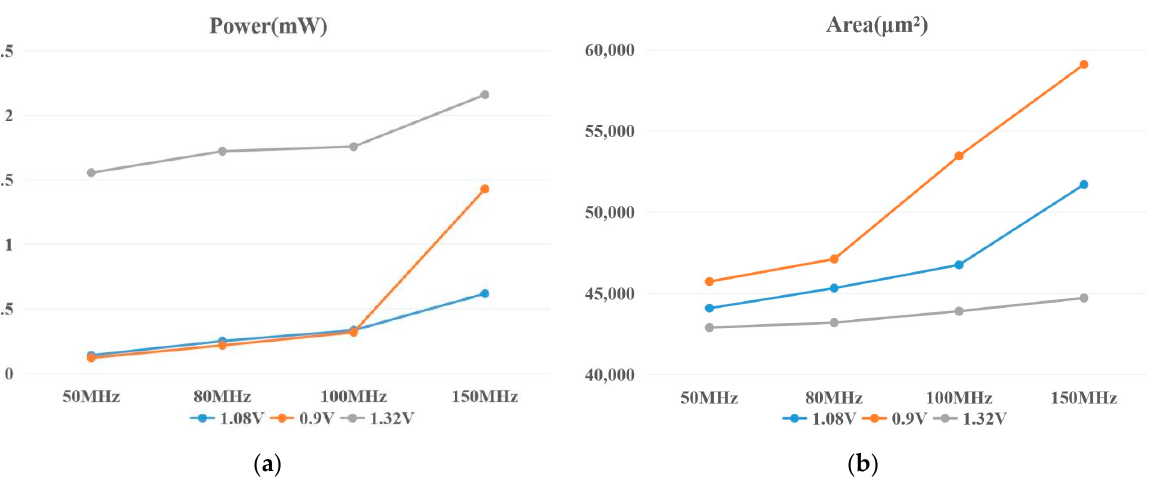
Figure 6. Power consumption of DCIM-FF with various supply voltages ( a ). Area overhead of DCIM-FF with various supply voltage ( b ). Table 3. Comparison of the proposed DCIM-FF with previous works.